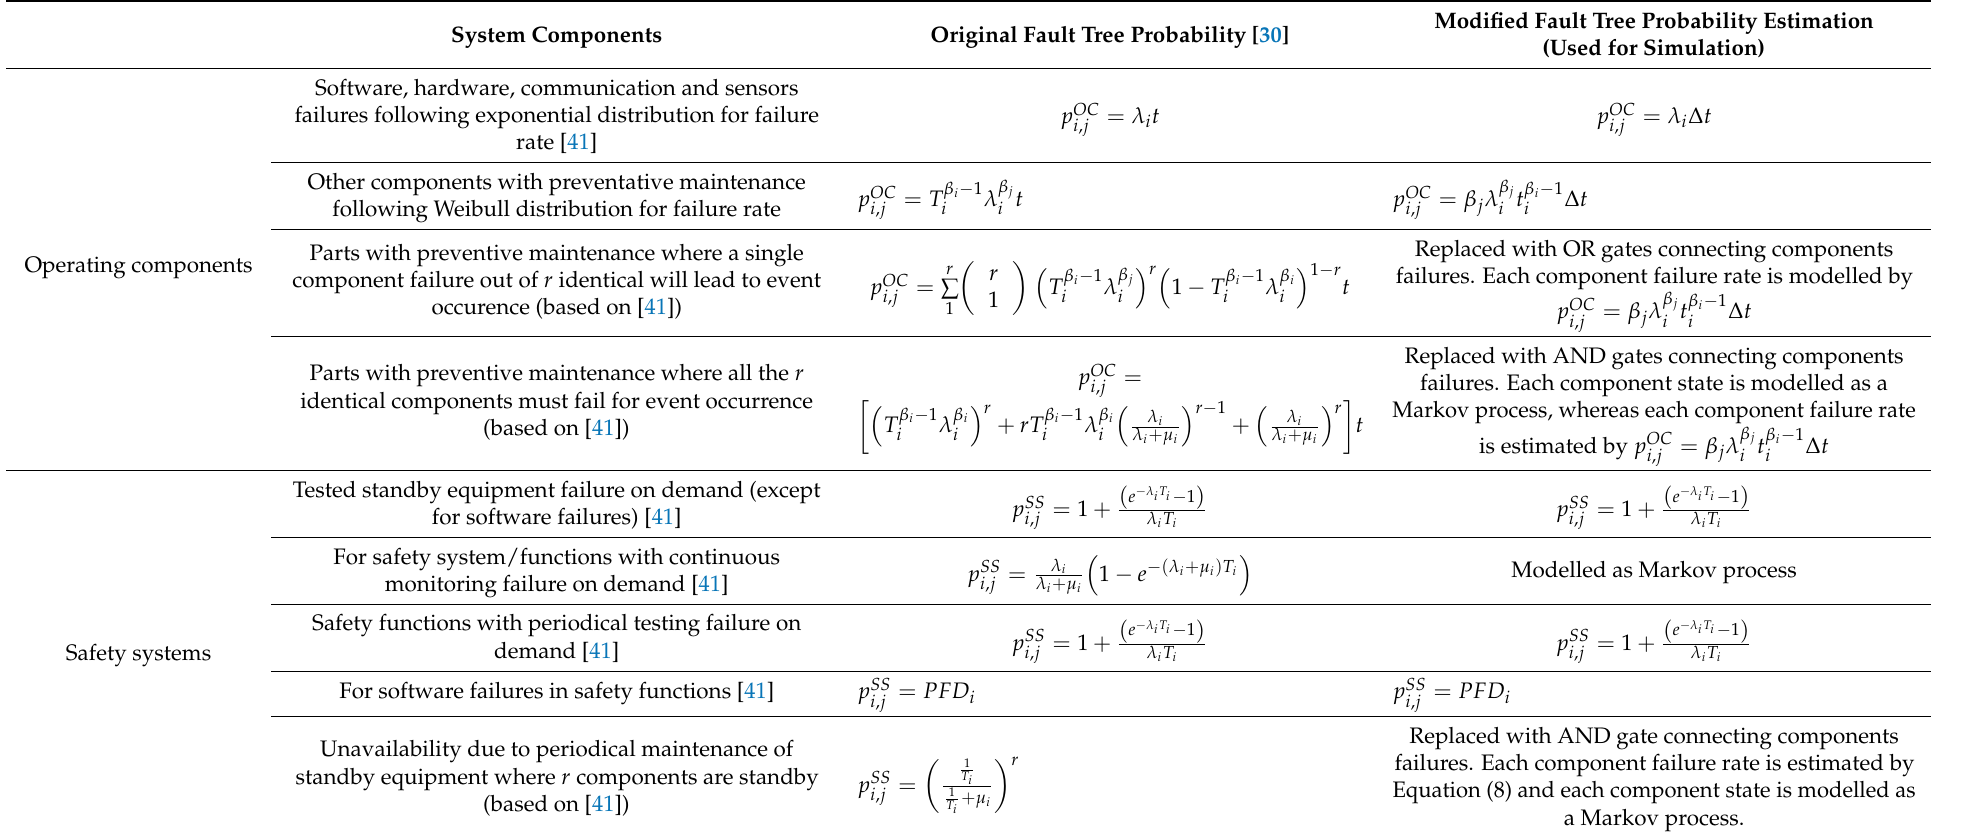
Table 2. Calculation of the basic events probabilities according to CASA and the in the performed